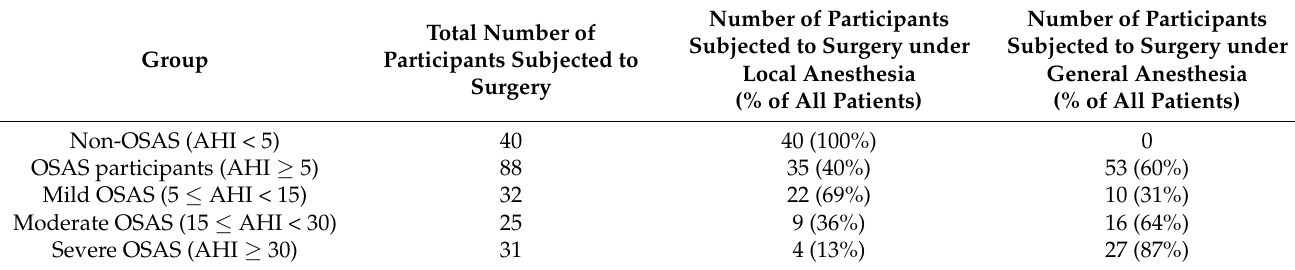
Table 3. Type of the surgery performed in the participants with obstructive sleep apnea syndrome (OSAS) and in non-OSAS participants.